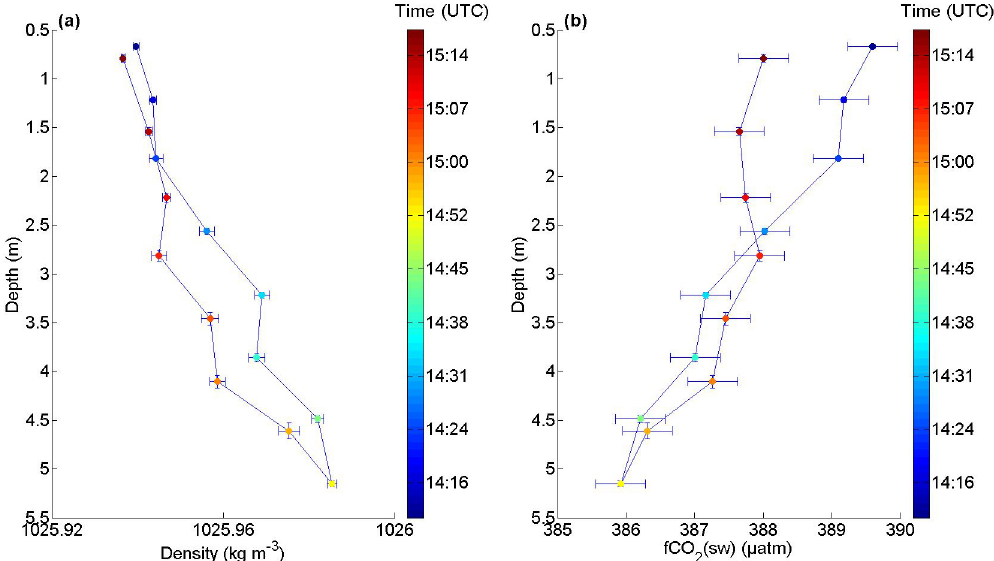
Figure 7. NSOP density (a) and f CO 2 ( sw ) , (b) profiles from the Celtic Sea on 30 July 2015. Data points are coloured by sample time. Vertical error bars correspond to 2 standard errors of the mean in each depth bin. The horizontal error bars in (a) are 2 standard errors of the mean, whereas in (b) they are the propagated error from the binned measurements used to calculate f CO 2 ( sw ) .